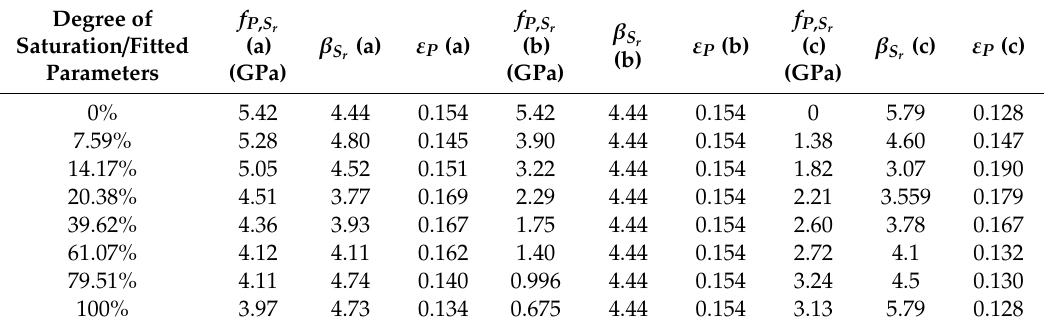
Table 4. The parameters fitted by Equation (4) in Figure 6.